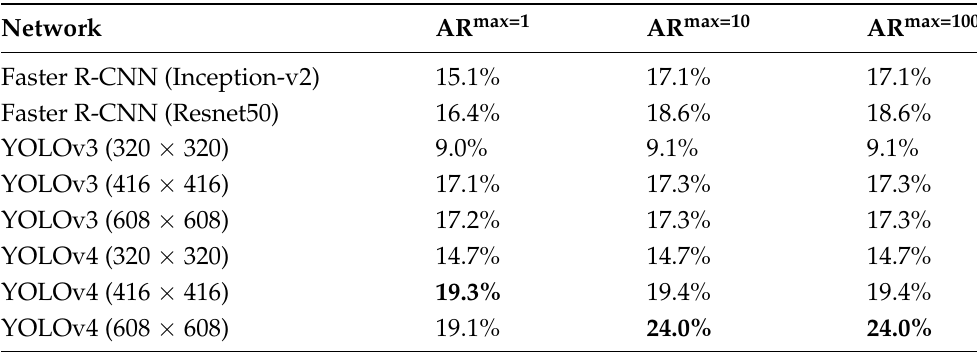
Table 8. Average recall for a given maximum number of detections, averaged over all values of IoU (0.5, 0.6, 0.7, 0.8, and 0.9) (Intersection over Union), on the Stanford dataset. The best results are marked in bold.